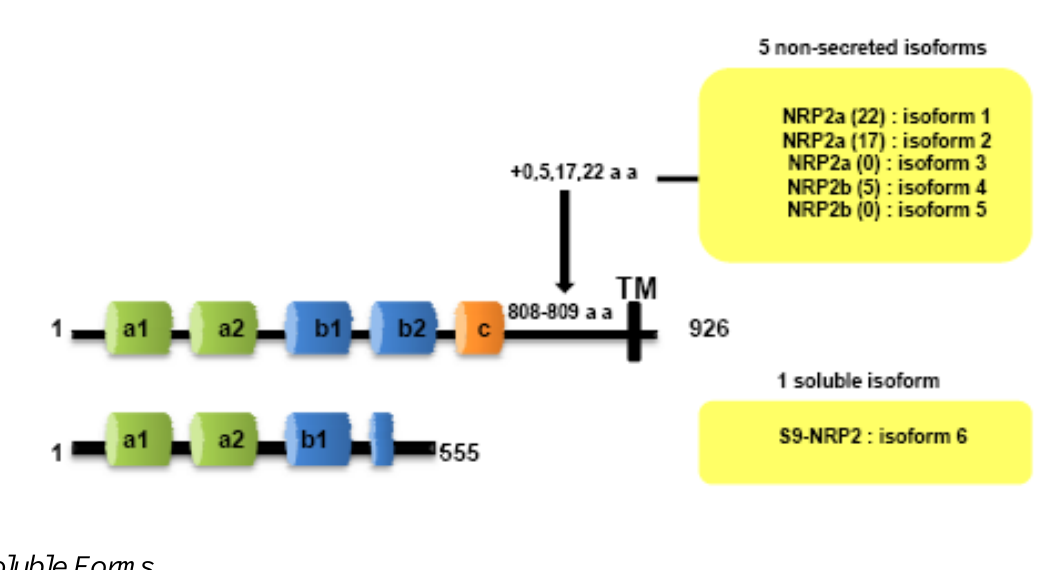
Figure 2. NRP2 transcript variants encode distinct